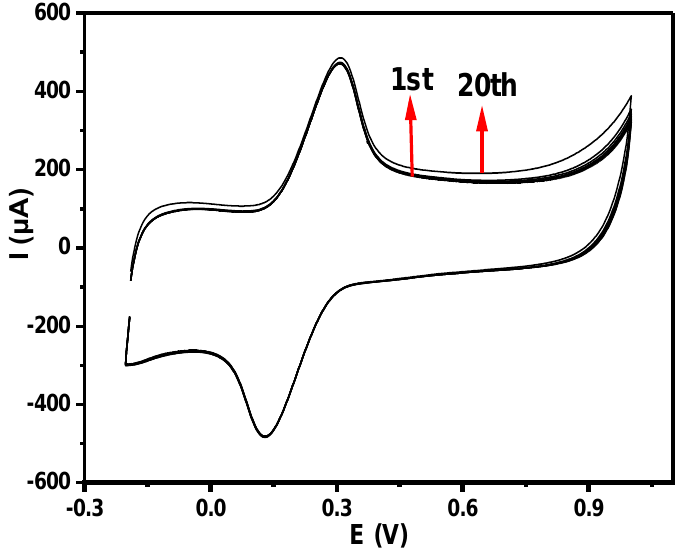
Figure 9. Cyclic voltammograms of 20 scans of GCE-NiPcMWCNTs-modified electrode in 5 mM [Fe(CN) 6 ] 3 − /4 − solution produced in 0.1 M PBS at pH 7 (scan rate 25 mVs −1 ).